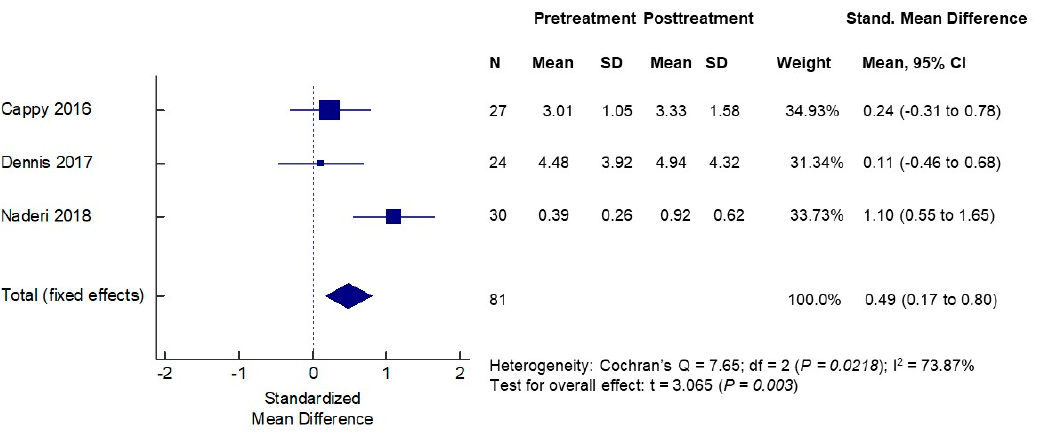
Figure 4. Effects of vitamin D supplementation on serum AMH levels—PCOS women.